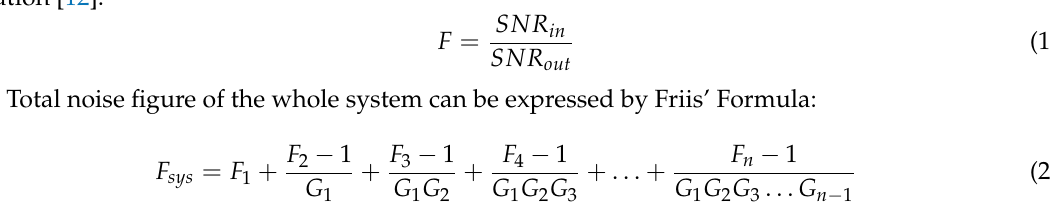
Figure 5. The proposed architecture for noise reduction.